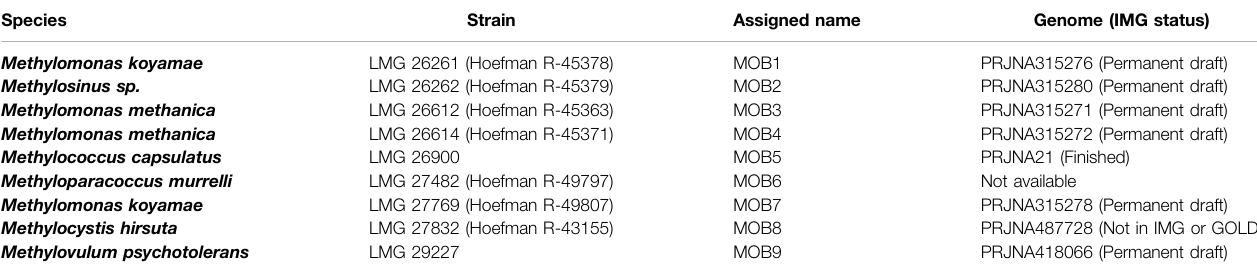
TABLE 1 | Methanotrophic bacteria used in the present study, with collection number and genome accession (if available).